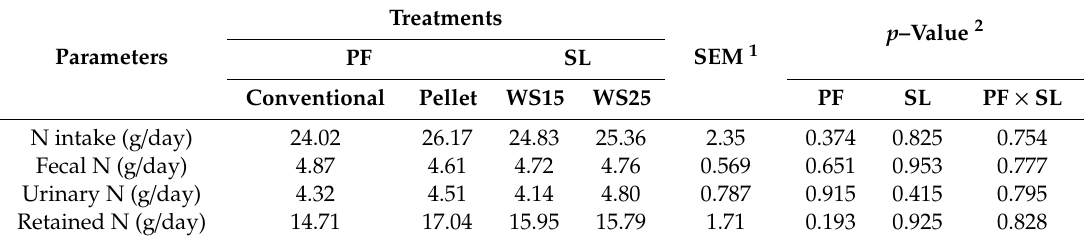
Table 6. E ff ects of conventional and pelleted TMR on nitrogen balancing in fattening goats. Treatments Parameters